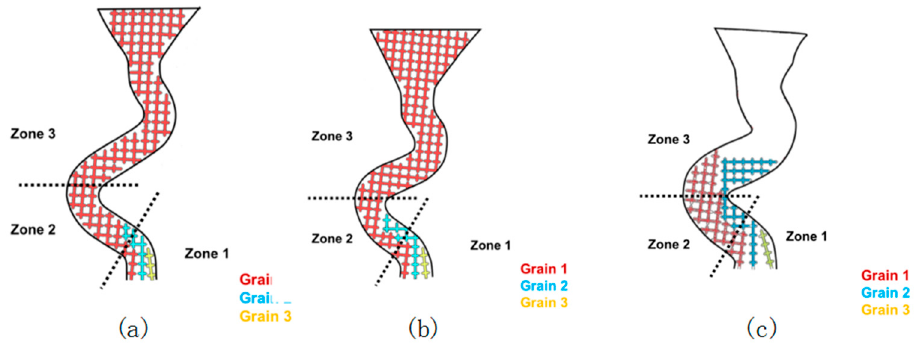
Figure 6. Schematic diagram of the grain selection process in Z-form grain selectors with different diameters: 2.6mm ( a ), 3.0mm ( b ), 6.0mm ( c ).